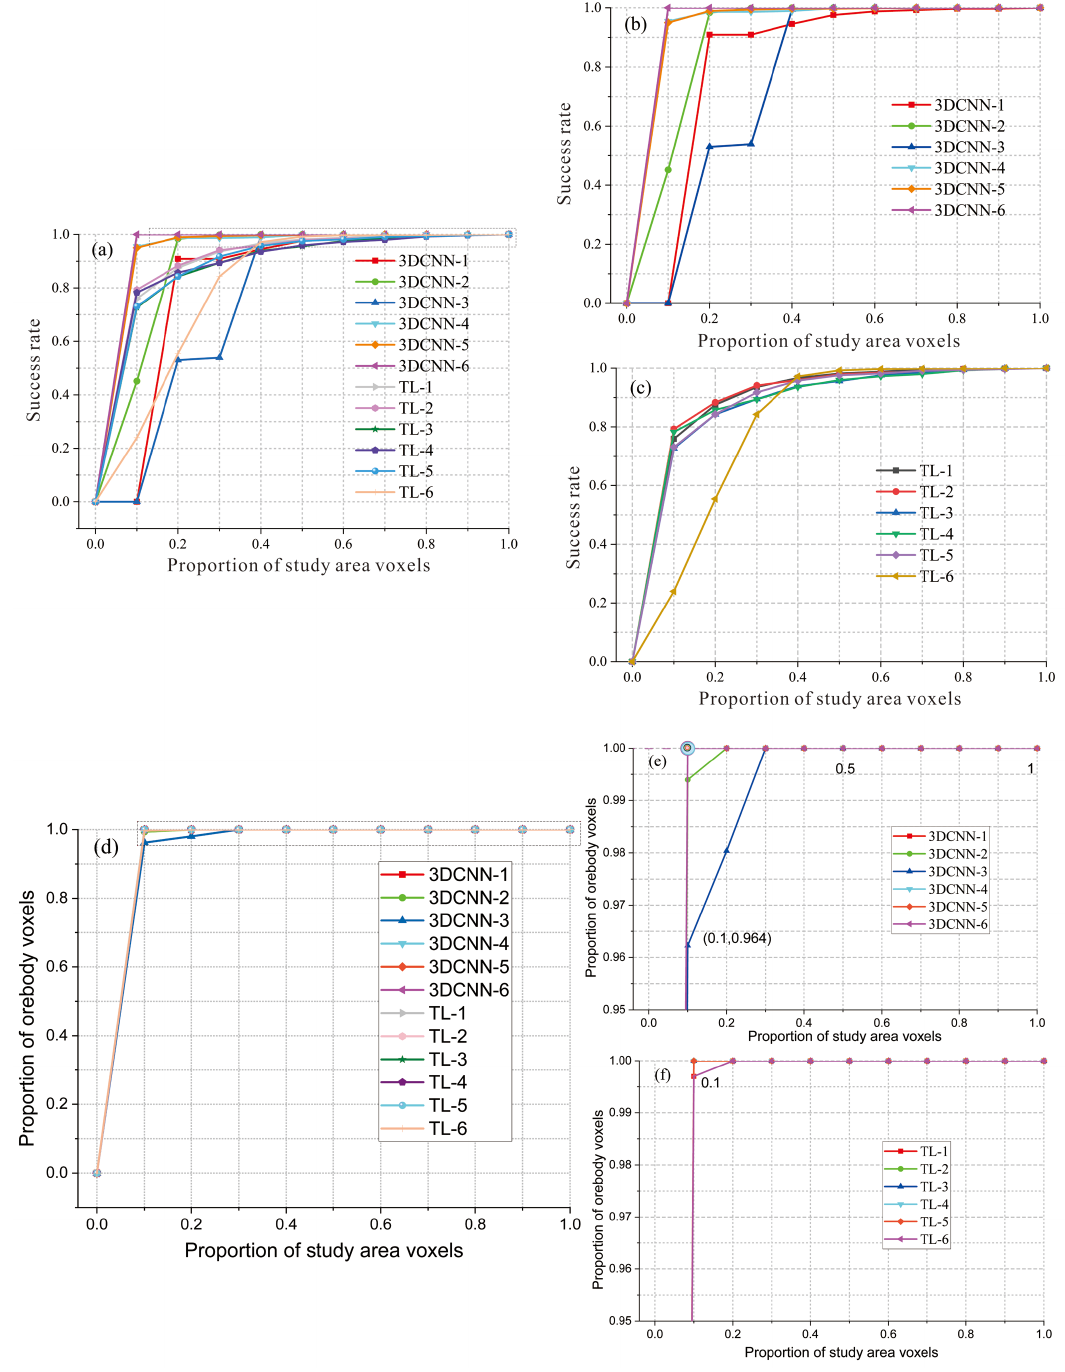
Figure 15. The performance evaluation curves of mineral prediction by the 3D CNN model and the 3D CNN-TL model in six tests. ( a , d ) show the success rate curve and ore-controlling rate curve of twelve tests, respectively. ( b ) shows the success rate curve of the 3D CNN model in six tests. ( c ) shows the success rate curve of the 3D CNN-TL model in six tests. ( e , f ) were plotted by extracting the ore-controlling rate between 0.95 and 1 of the curve in ( d ). ( e ) shows the ore-controlling rate curve of the 3D CNN model in six tests. ( f ) shows the ore-controlling rate curve of the 3D CNN-TL model in six